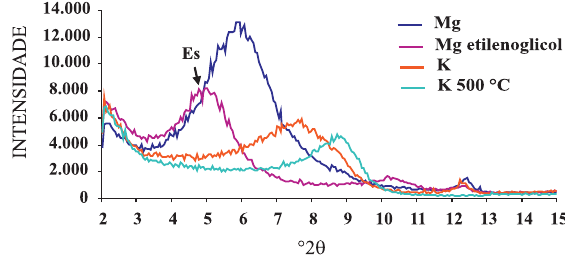
Figura 6. Difratogramas de raios X de amostras orientadas de argila desferrificada do horizonte C4 do Setor de Ciências Agrárias (SCA) da UFPR, submetidas aos tratamentos auxiliares. Es - esmectita. Espaçamento basal d(001): Mg - 1,5 nm; Mg etilenoglicol - 1,80 nm; K - 1,15 nm; K 550 °C - 1,00 nm.